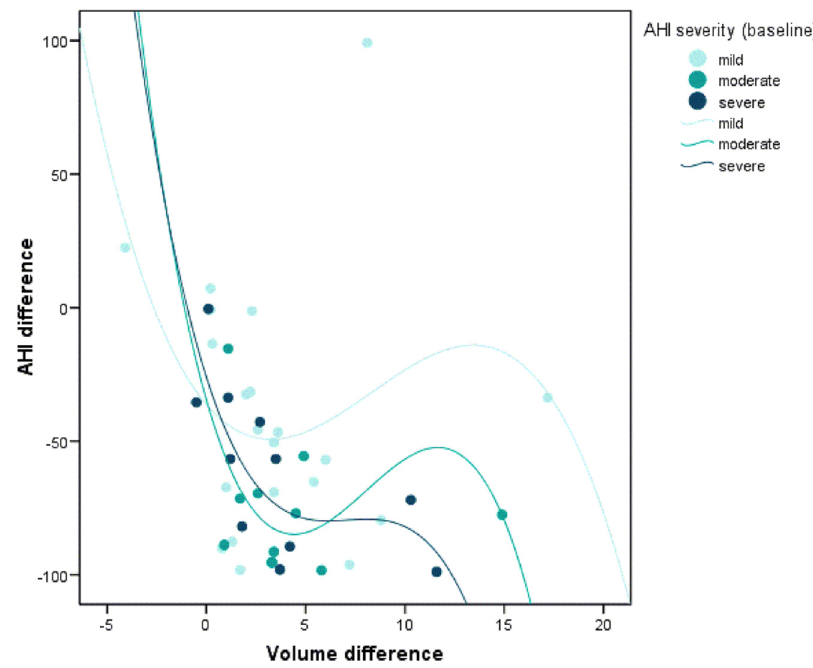
Figure 8. Correlation between the changes in AHI after MAD titration and the volumetric changes of the upper airway according to the OSA severity ( p = 0.002).